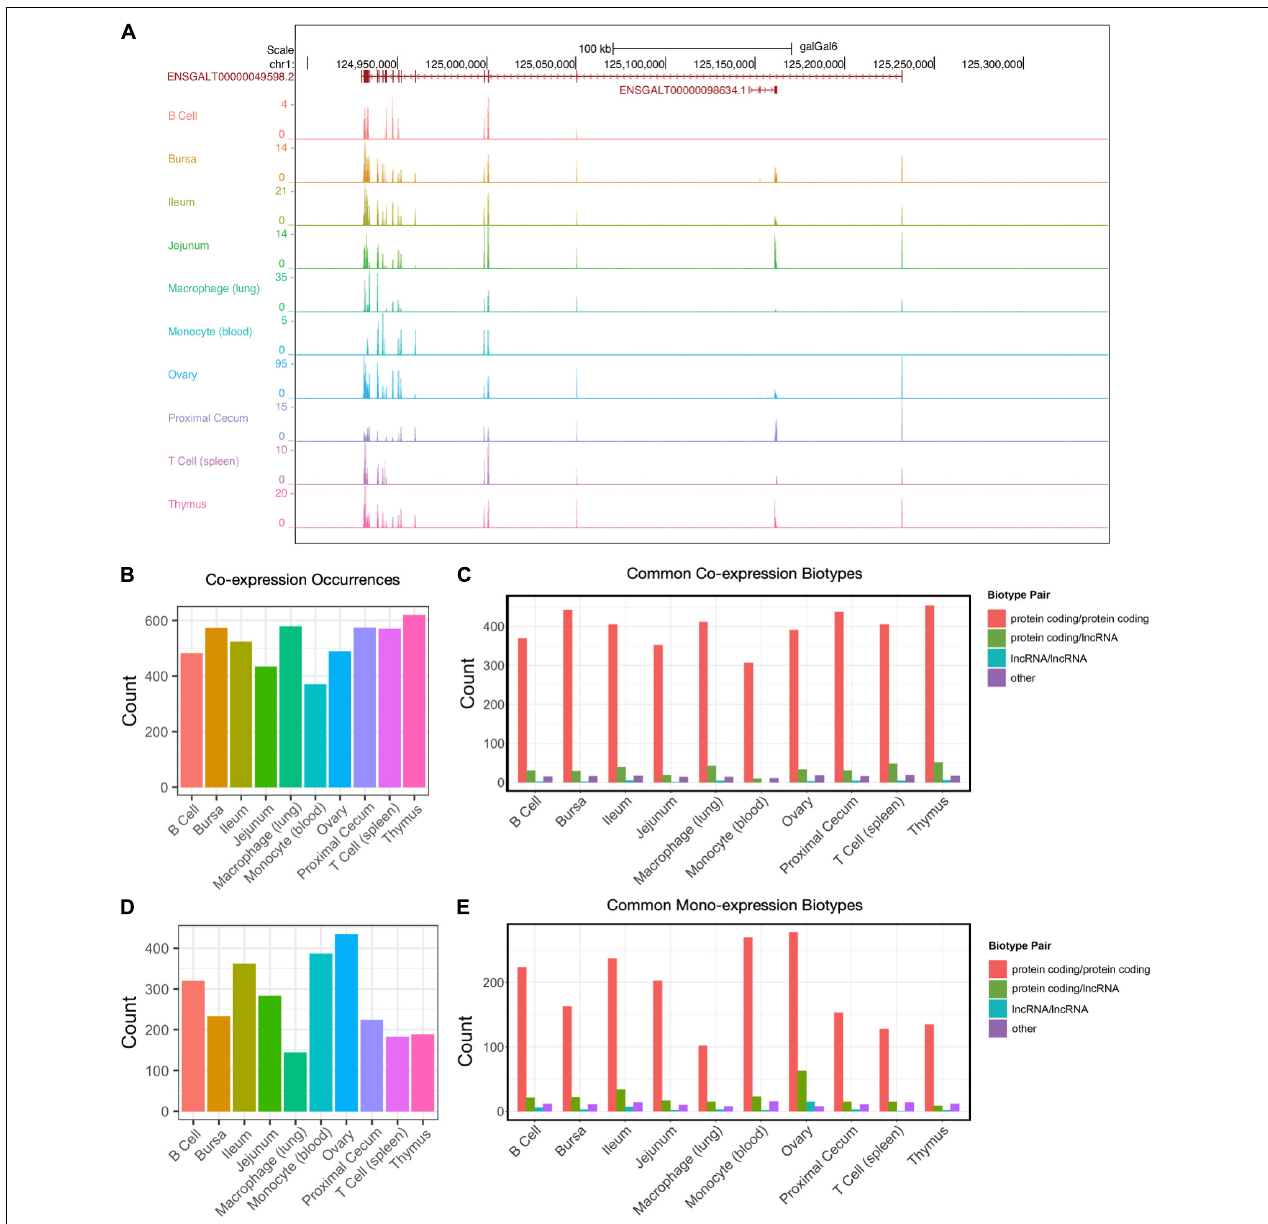
FIGURE 4 | Forward–reverse strand co-expression. (A) Example of co-expressed transcripts on the forward and reverse strands. ENSGALT00000049598/ FRMPD4 (reverse strand) and ENSGALG00000098634 (forward strand) are overlapping in their genomic coordinates. (B) The number of co-expression occurrences in each tissue type. (C) Co-expression counts of protein-coding RNAs and lncRNAs. (D) The number of mono-expression occurrences in each tissue type. (E) Mono-expression of protein-coding RNAs and